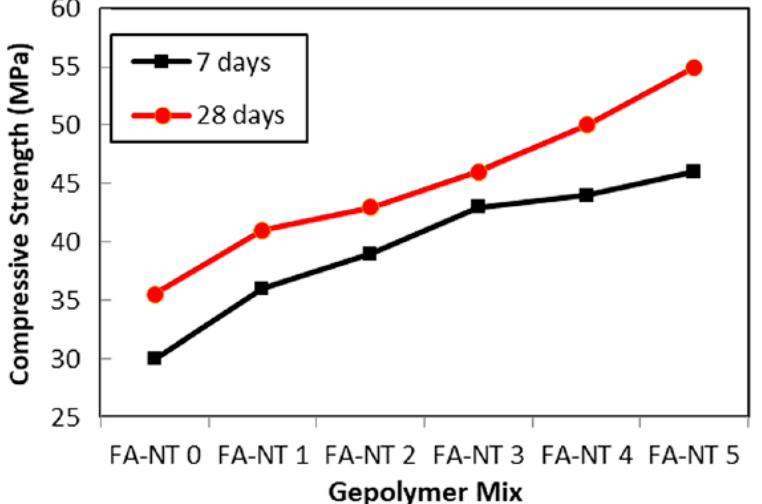
Figure 9. Strength development of FA-based mixes enclosing various levels of nano-TiO 2 [178].